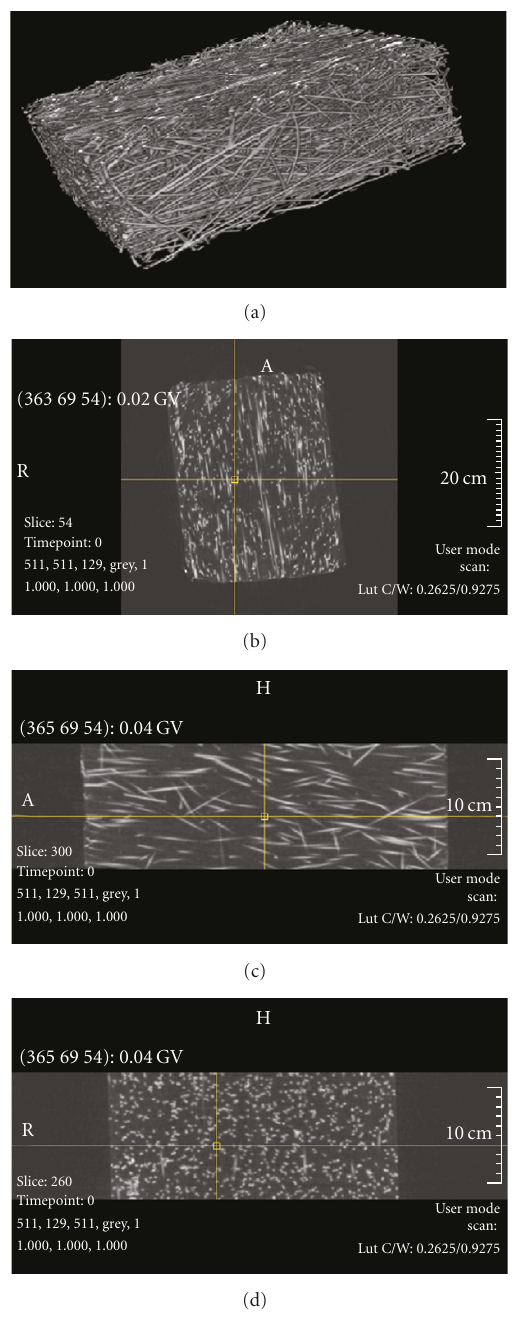
Figure 13: Real product sample two. Fiber length is medium to short. The fibers are packed more loosely than in dataset one, but exhibit a higher curvature and show a high amount of overlap.